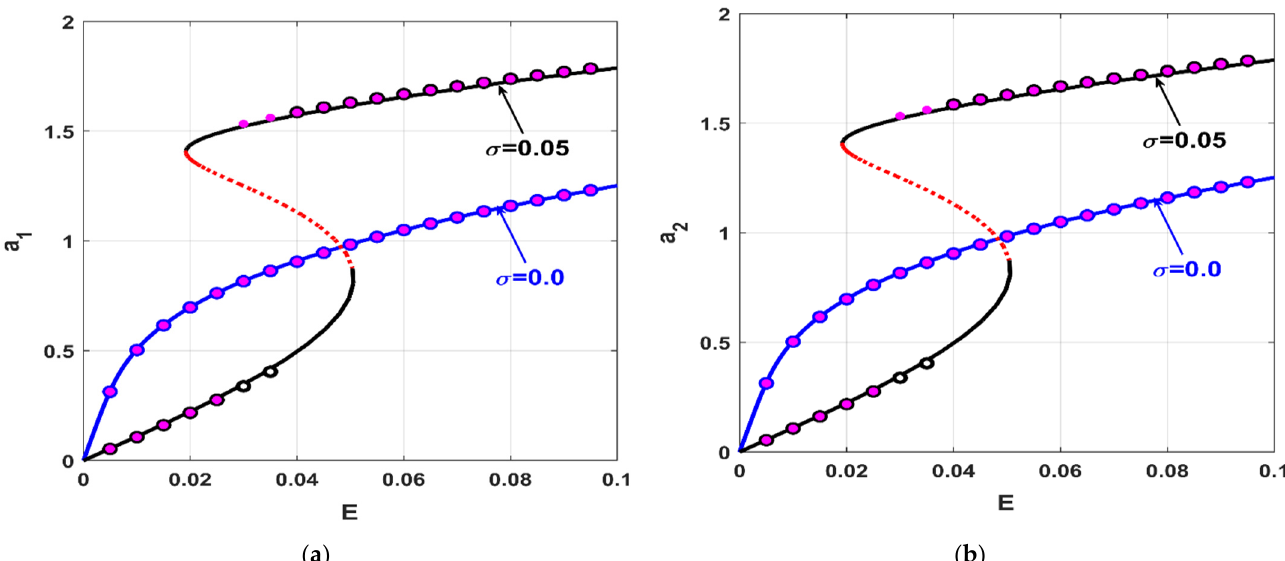
Figure 5. 𝐸 − response curves of the uncontrolled Jeffcott rotor at various values of 𝜎 : ( a ) oscillation Figure 5. E —response curves of the uncontrolled Jeffcott rotor at various values of σ : ( a ) oscillation amplitude in 𝑋 − direction ( 𝑎 (cid:2869) ) versus the eccentricity ( 𝐸 ), and ( b ) oscillation amplitude in 𝑌 − di- amplitude in X —direction ( a 1 ) versus the eccentricity ( E ), and ( b ) oscillation amplitude in Y —direction rection ( 𝑎 (cid:2870) ) the eccentricity ( 𝐸 ). ( a 2 ) the eccentricity ( E